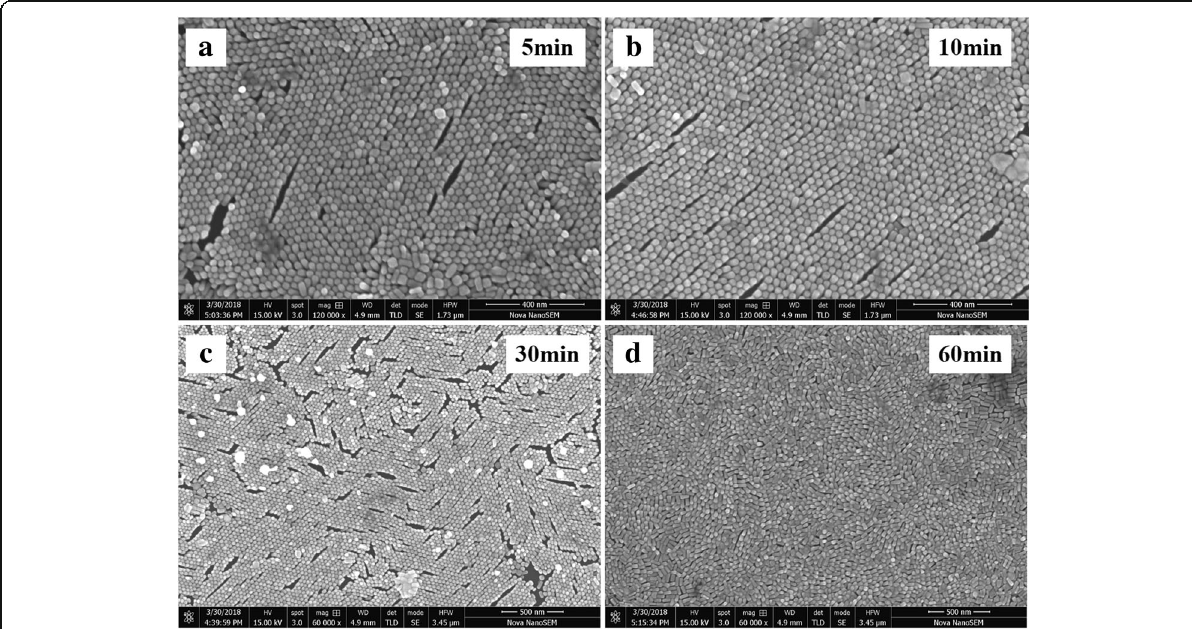
Fig. 4 a – d SEM images of GNR arrays with different soaking times. The soaking time of GNR arrays is 5 min, 10 min, 30 min, and 60 min, respectively